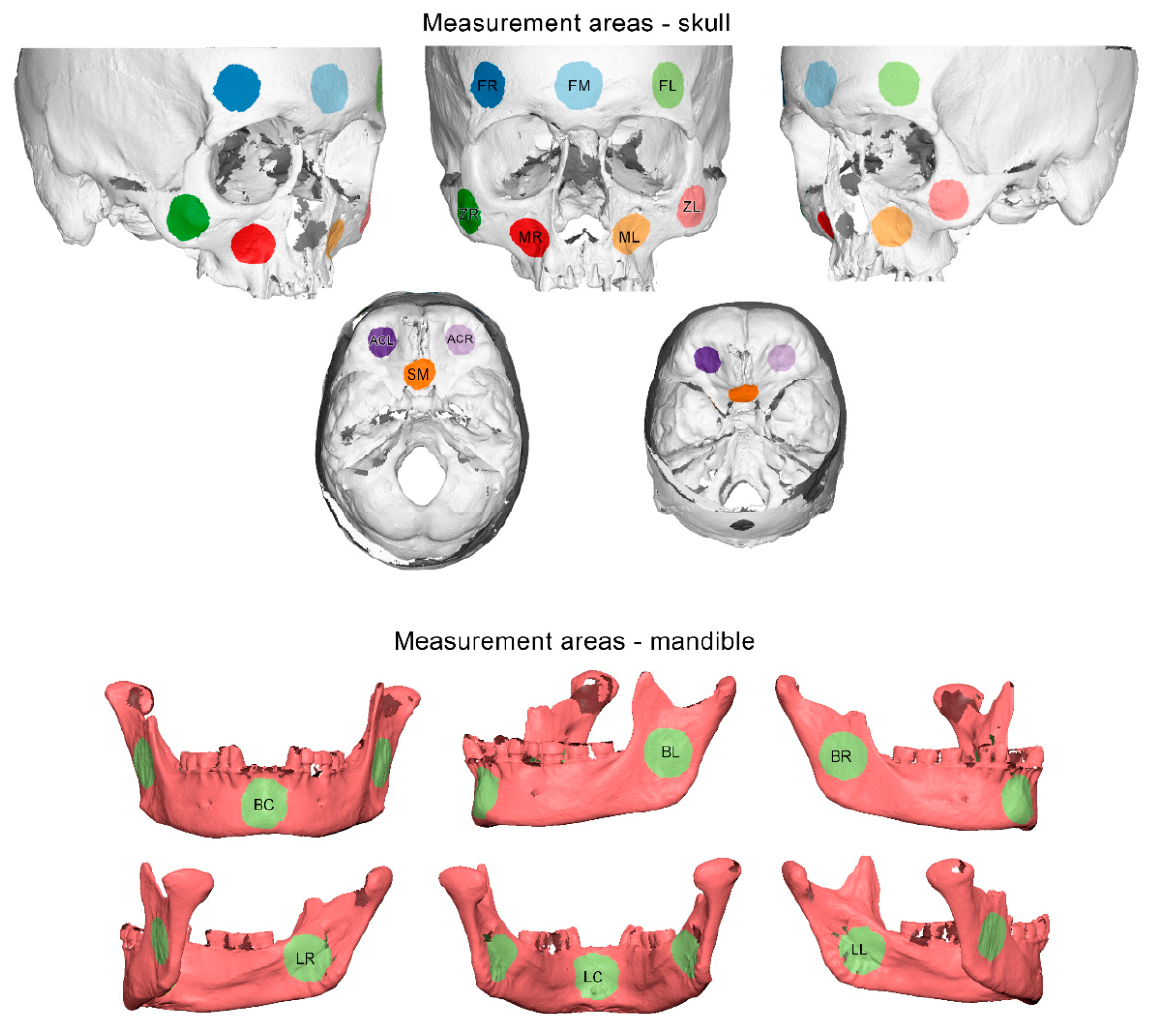
Figure 3. Measurement areas used to assess differences between corresponding 3D surface models shown as colored round surfaces. Skull: forehead left (FL), right (FR), and middle (FM), maxilla left (ML) and right (MR), zygomatic bone left (ZL) and right (ZR), anterior cranial base left (ACL) and right (ACR), and sphenoid bone middle (SM). Mandible: upper row: buccal left (BL), right (BR), and center (BC). Bottom row: lingual left (LL), right (LR), and center (LC).